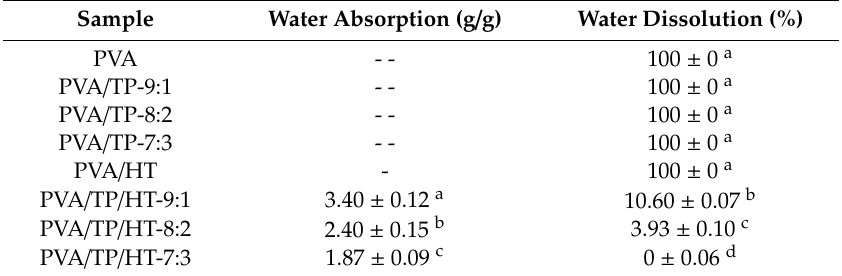
Table 1. Water absorption and dissolution rate results of each group of